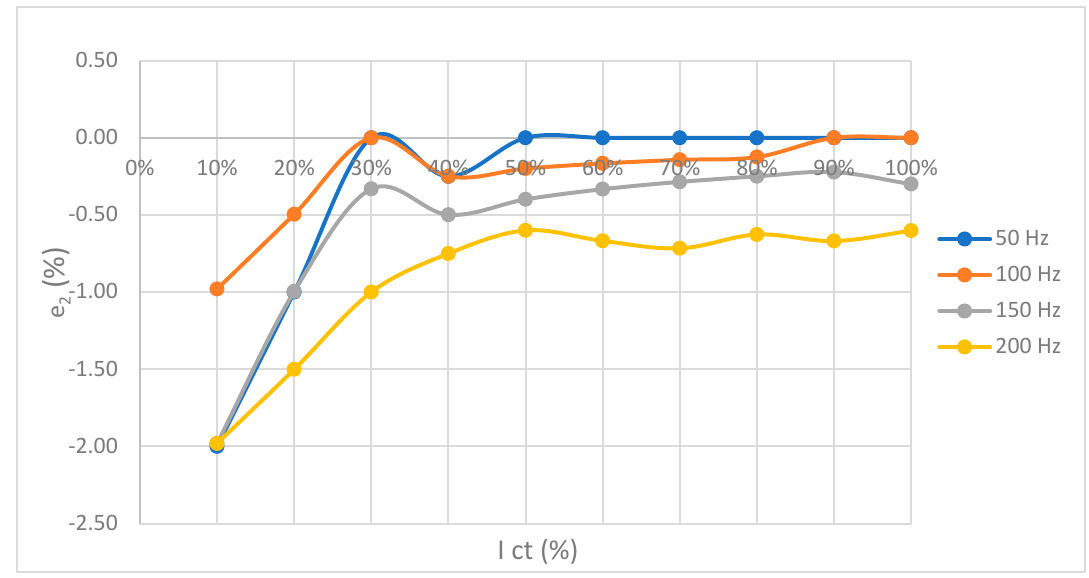
Figure 11. Display of the ammeter calibration curve at a temperature of 26.3 °C.